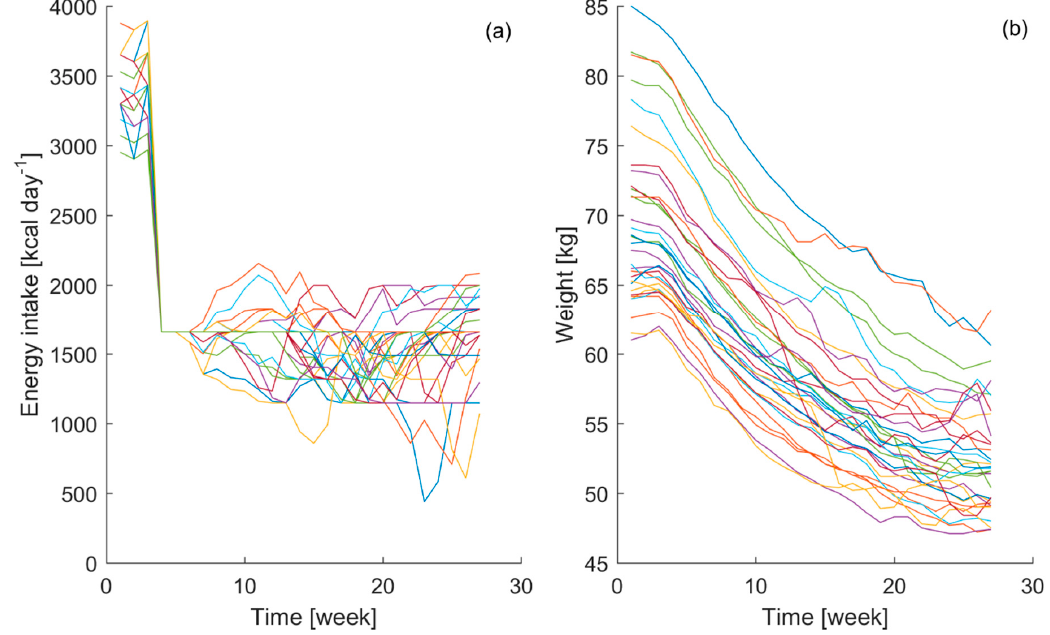
Figure 1. Energy intake in kcal day -1 ( a ) and bodyweight in kg ( b ) curves collected for each one of the 32 participants in the Minnesota starvation.